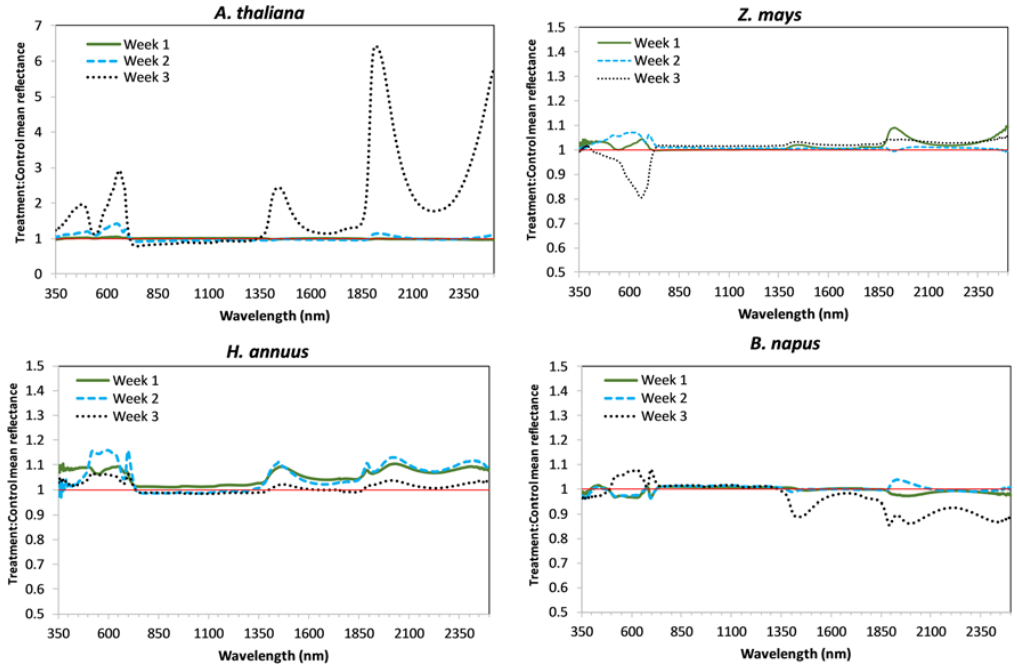
Figure 1. Relative reflectance of treatment to control for each of four species as acquired by CP.